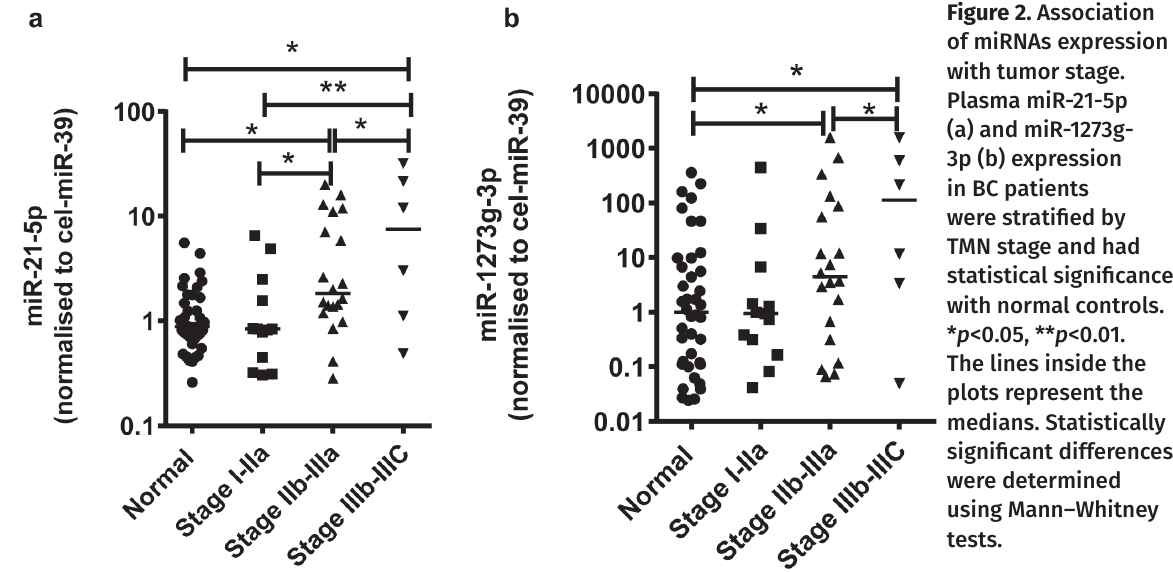
Figure 2. Association of miRNAs expression with tumor